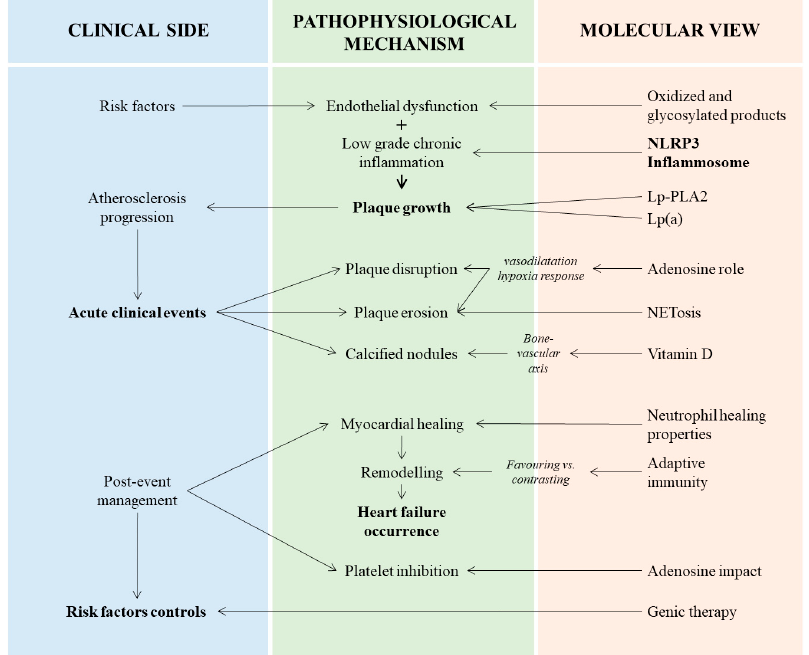
Figure 3. Interplay between clinical manifestations, pathophysiological mechanisms and main actors related to atherosclerosis in acute coronary syndromes. In the left column are the three main clinical steps of acute coronary syndrome: pre-clinical atherosclerosis progression, acute event occurrence and post-event management. In the center column are the principal signaling pathways and underlying pathological aspects. In the right column are the key elements and substances me- diating the pathophysiological process. Lp(a), lipoprotein(a); Lp-PLA2, lipoprotein associated- phospholipase A2; NETosis, neutrophil extracellular traps (NETs) formation; NLRP3, nucleotide- binding oligomerization domain-like receptor family pyrin domain containing 3.